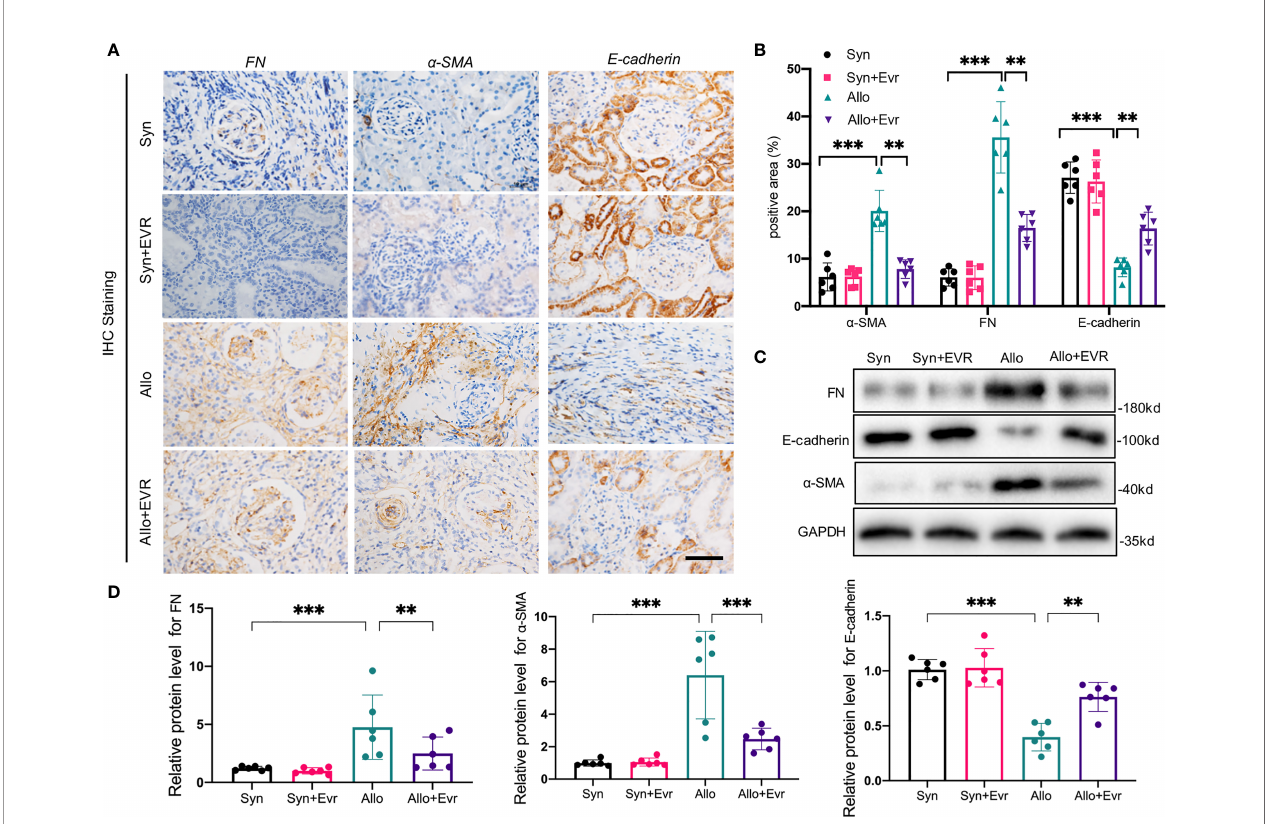
FIGURE 2 | EVR alleviated the progression of renal tubular EMT in CAD rat model. (A) Representative IHC images of EMT markers (E-cadherin, a -SMA, and FN) in kidney sections from different treatment group rats (scale bar: 20 m m). (B) Semi-quantitative analyses results of IHC positive area in kidney sections from different treatment group rats. Values represented the mean ± SD ( n = 6, ** p < 0.01, *** p < 0.001). (C) Representative Western blotting results of EMT markers (E-cadherin, a -SMA, and FN) in kidney tissues from different treatment group rats. (D) Semi-quantitative analyses results of relative protein abundances of E-cadherin, a -SMA, and FN in kidney tissues from different treatment group rats. Values represented the mean ± SD ( n = 6, ** p < 0.01, *** p < 0.001); IHC, immunohistochemistry; a - SMA, a -smooth muscle actin; EVR, everolimus; EMT, epithelial – mesenchymal transition; FN, fi